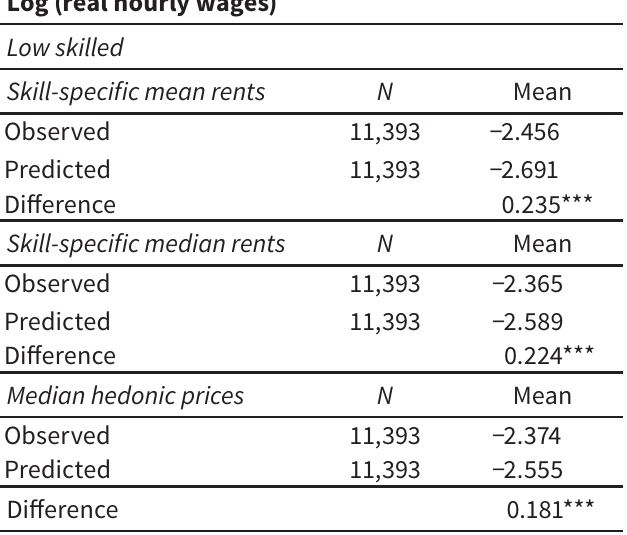
Observed and predicted real wage differences using different measures of living